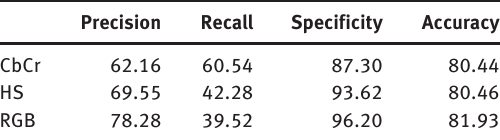
Table 5. Accuracy Results for CbCr, RGB, and HS on the UCD Database.